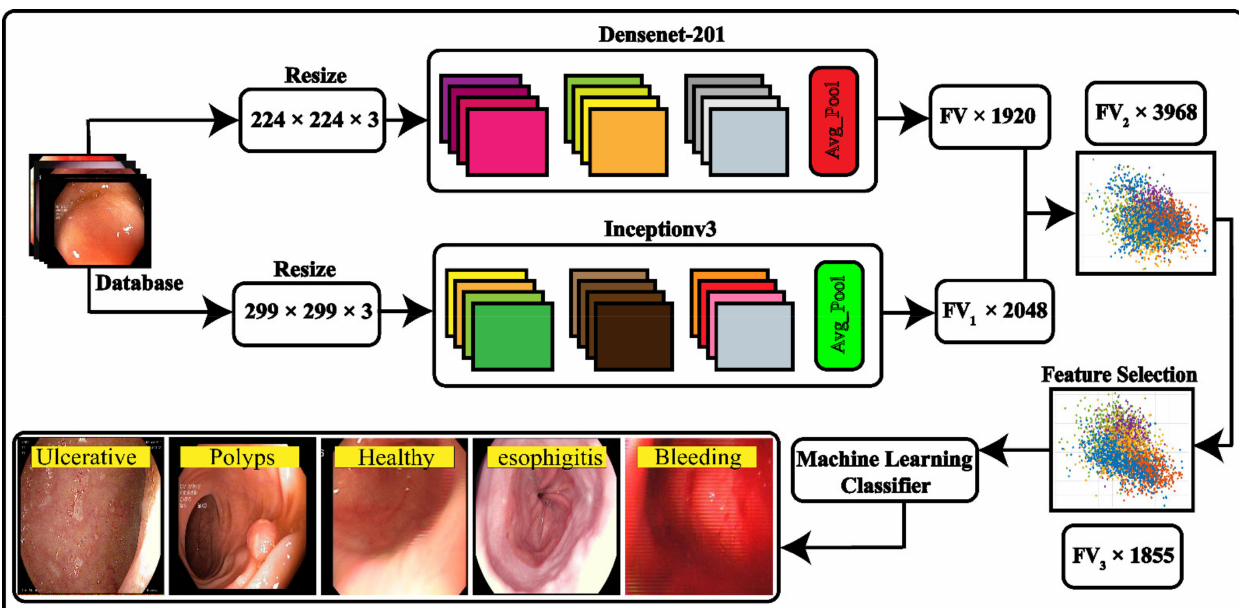
Figure 1. Proposed technique for stomach disease classification.